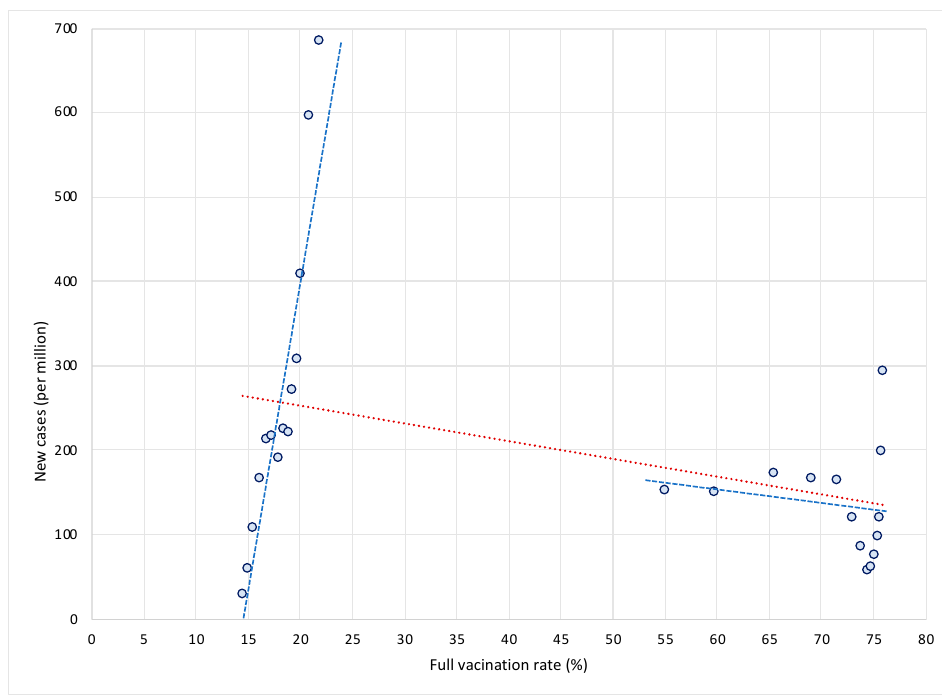
Figure 1. New COVID cases and vaccination rates in Bulgaria and Denmark, by weeks. Notes: Data by weeks, period 1 August to 31 October 2021. Left part of the figure shows data for Bulgaria. Source: Our World in Data; own calculations.